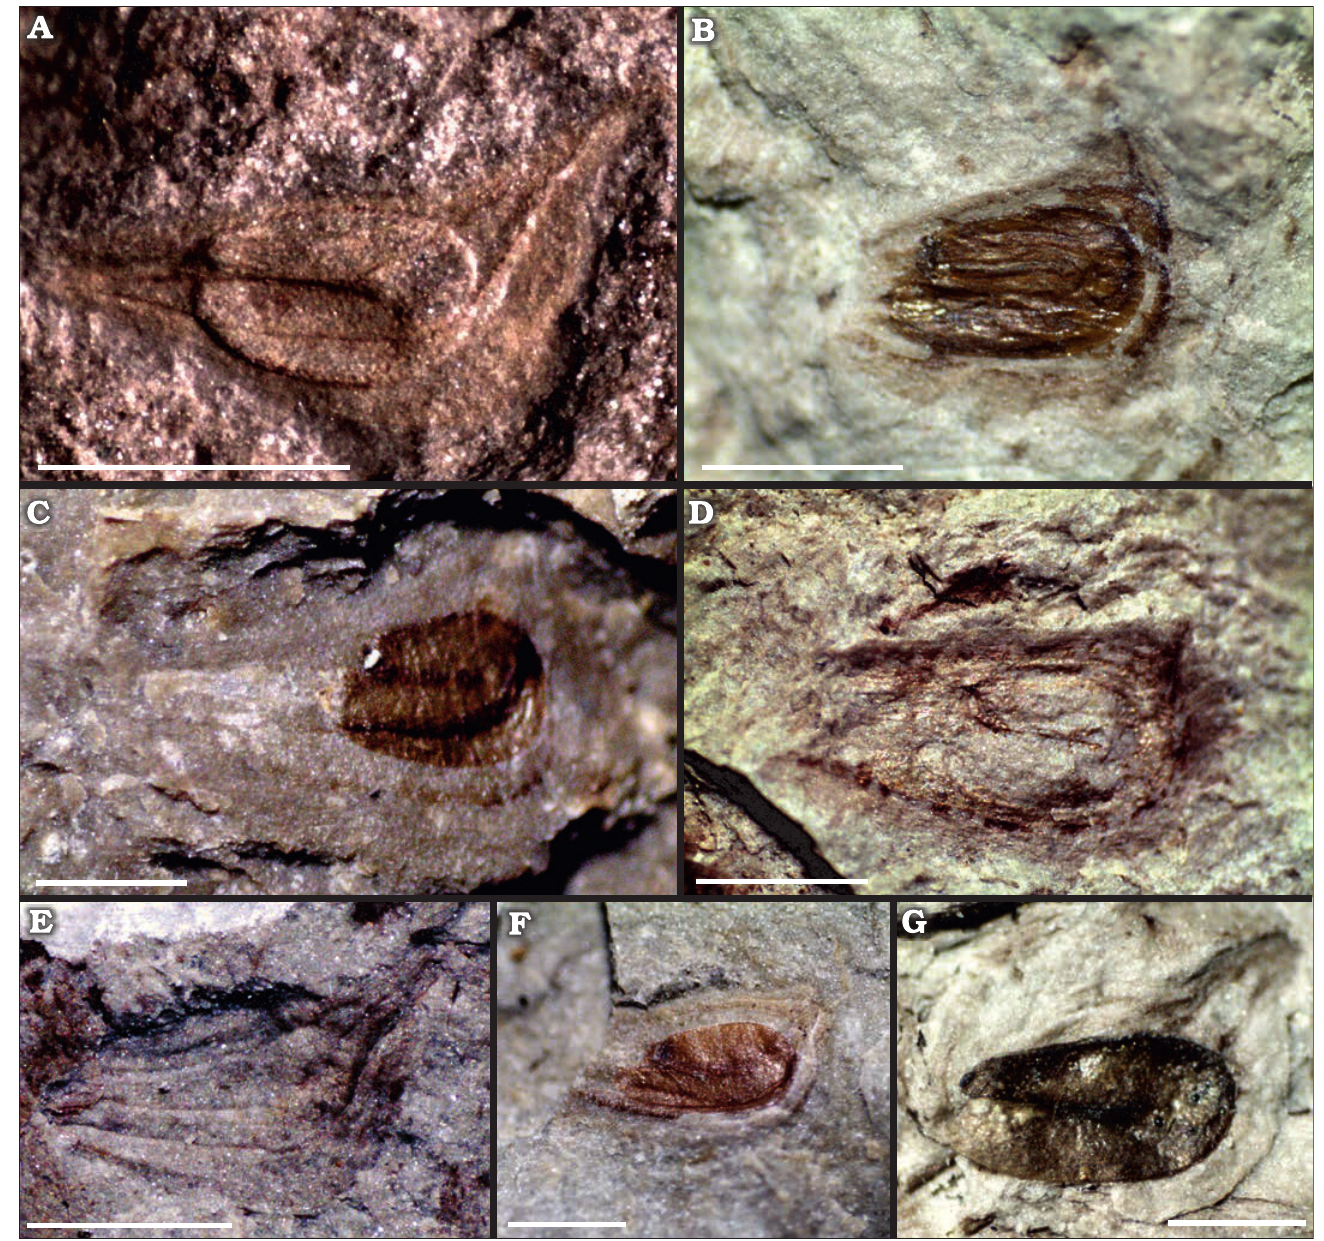
Fig. 4. Achenes of alismataceous plant Sagittaria montevidensis Chamisso and Schlectendal, 1827, from the Palo Pintado Formation, Quebrada El Estanque and Quebrada Salta localities, upper Miocene. A . Complete achene where the recurved seed and several veins are visible, CTES-PB 12911. B . Specimen showing the well-developed beak, almost in straight angle with the ventral face, CTES-PB 12916. C . Complete achene with organic remains, CTES-PB 12914. D . Fragment of achene where the beak and bottom are lacking, CTES-PB 12917. E . Complete fruit showing several veins, CTES-PB 12912. F . Incomplete achene where the bottom and beak are lacking, but the seed preserves some organic remains , CTES-PB 12913. G . Specimen show- ing the well - preserved seed inside the achene, CTES-PB 12915. Scale bars